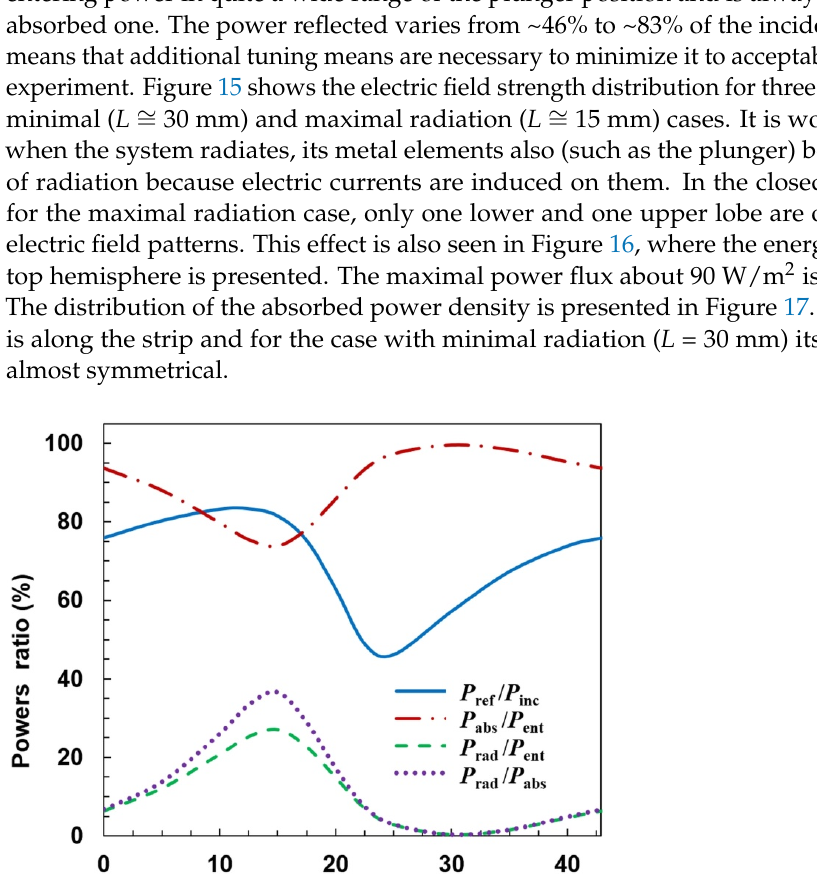
Figure 15. Spatial distributions of the log 10 of | E |/(1 Vm − 1 ) in x - y plane passing through the center of the plasma for P ent = 100 W and closed configuration. ( a ) L = 15 mm, ( b ) L = 20 mm, and ( c ) L = 30 mm. The scale is the same as in Figure 7. The scale on the left shows dimensions in mm. Figure 16. Distributions of the power flux, W, on the top part of the radiation sphere (with radius 300 mm) for P ent = 100 W and closed configuration. ( a ) L = 15 mm, ( b ) L = 20 mm, and ( c ) L = 30 mm. The scale is the same as in Figure 8. The scale on the left shows dimensions in mm.